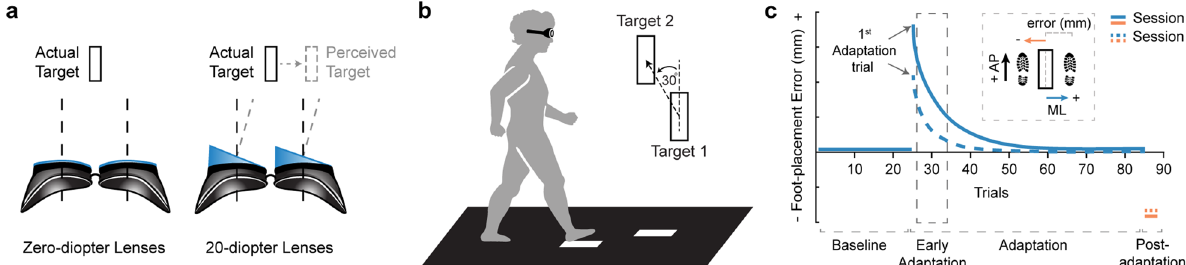
Figure 1. Experimental setup and protocol. ( a ) A simulated view of a target through the goggles coupled with zero-diopter (non-visual-field-shifting) lenses and 20-diopter prism lenses that shift the perceived location of the target 11.4° to the right. ( b ) A schematic of the visually guided precision walking task. Participants walked and stepped with the right and left foot onto the center on two sequential targets on the ground. ( c ) An illustration of the predicted end-point error profiles for each phase of testing. All participants performed baseline, adaptation, and post-adaptation phases. Inset: Positive ( +) and negative ( −) medial–lateral (ML) foot- placement error. AP = anterior–posterior direction in motion capture